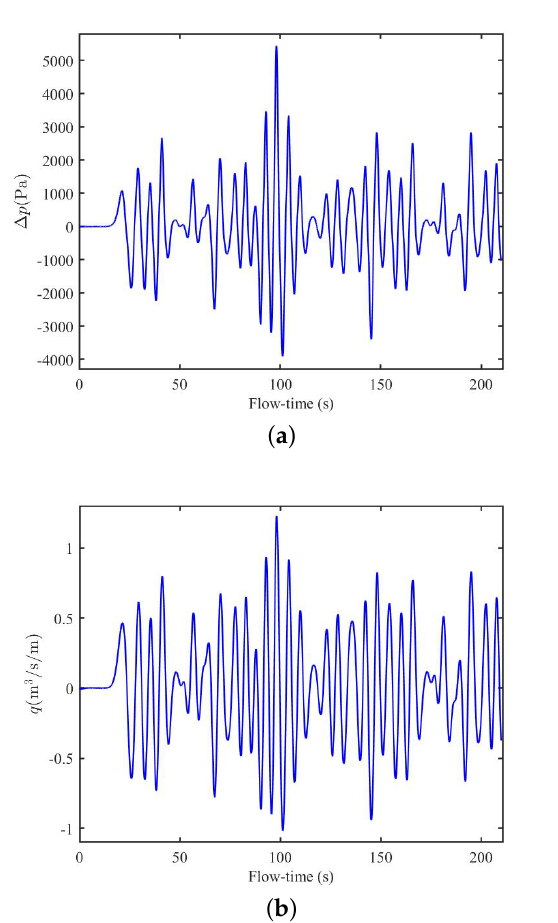
Figure 16. Variation in the ( a ) pressure drop, and ( b ) flow rate vs. the flow-time, with H s = 0.9 m and ω p = 1.25